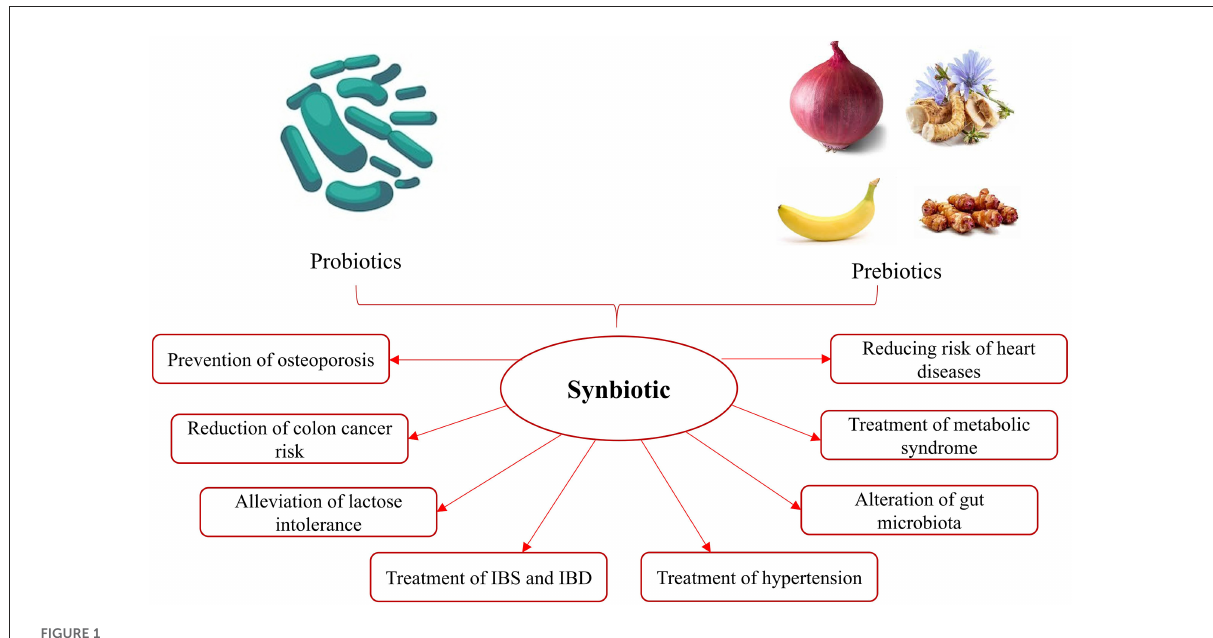
FIGURE1 Some health advantages of